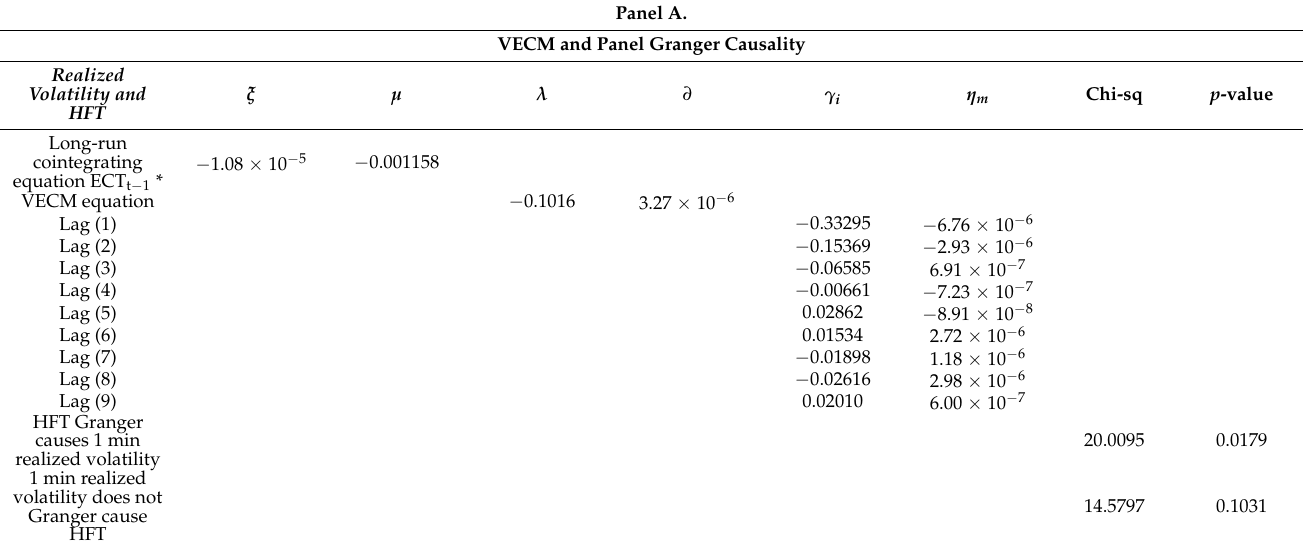
Table 7. Panel A. Panel Granger causality/block exogeneity Wald tests. Panel B. Panel Granger causality/block exogeneity Wald tests. Panel